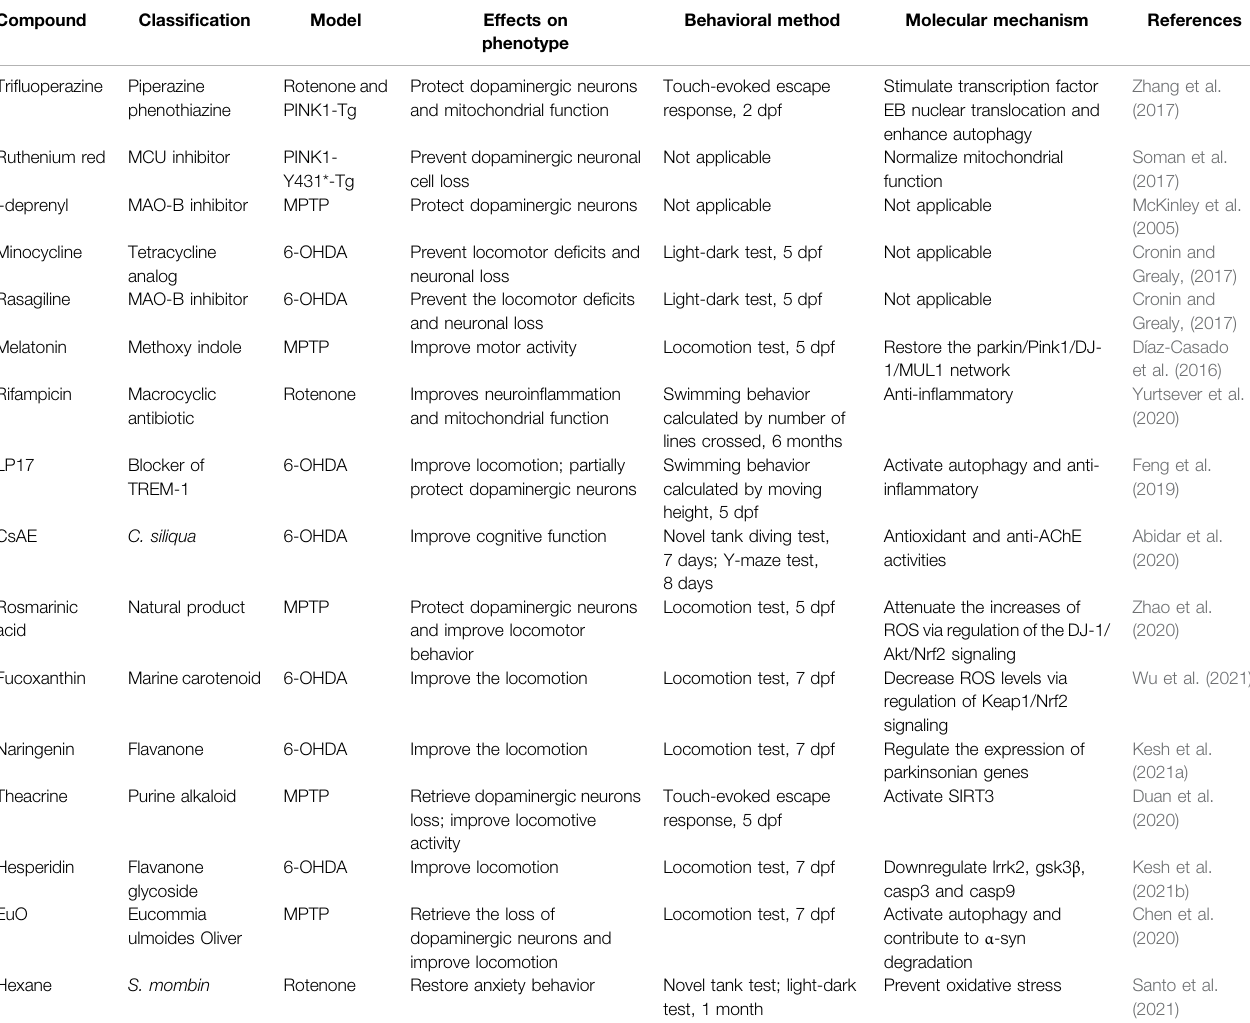
TABLE 2 | Drugs identi fi ed for PD treatment in zebra fi sh